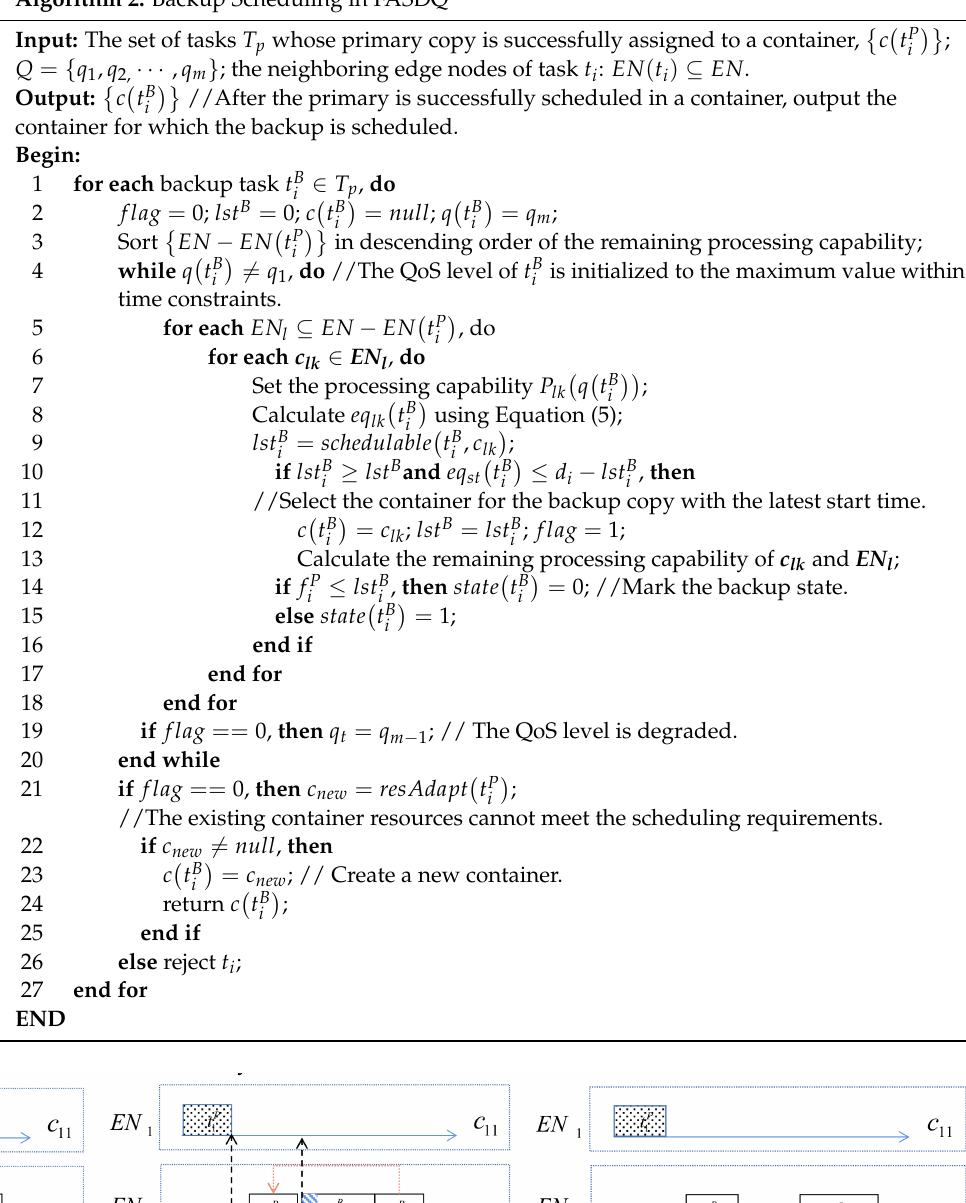
Algorithm 2. Backup Scheduling in FASDQ